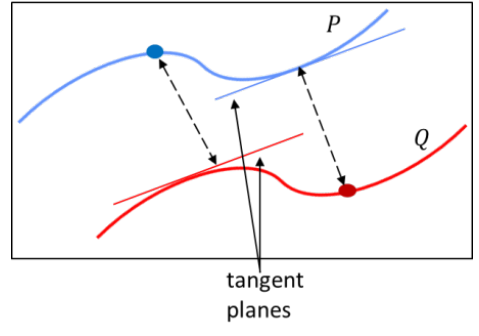
Figure 2. 2D Representation of P2P